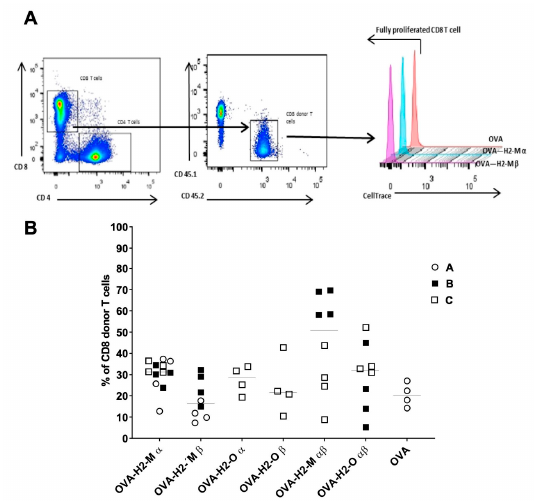
Figure 4. CD8+ T cell proliferation mediated by the insertion of H2-M and H2-O trafficking signal sequences. ( A ) In vivo quantification of CD8+ T cell proliferation generated by coupling OVA to selected trafficking signal sequences. Flow cytometry plots and histograms showing the analysis and quantification of the vital cell tracer dye decline staining in proliferating CD8+ T cells. CD45.1 mice were adoptively transferred i.v. with mouse CellTrace labeled CD45.2/CD8/OTII cells and 24 h later immunized i.v. with 5 µg of formulated OVA-fusion mRNAs. T cell proliferation was measured at 5 days post-DC transfer by flow cytometry after the staining. T cell proliferation was determined by measuring the percentage of CD8 proliferating T cells, as shown in the graph. All groups showed were fully proliferated. ( B ) In vivo CD8+ T cell expansion generated by coupling OVA to H2-M and H2-O sequences. Data in the graph represent the CD8 T cell expansion generated by H2-M and H2-O sequences. Three independent experiments are shown (A–C), four female mice per group.